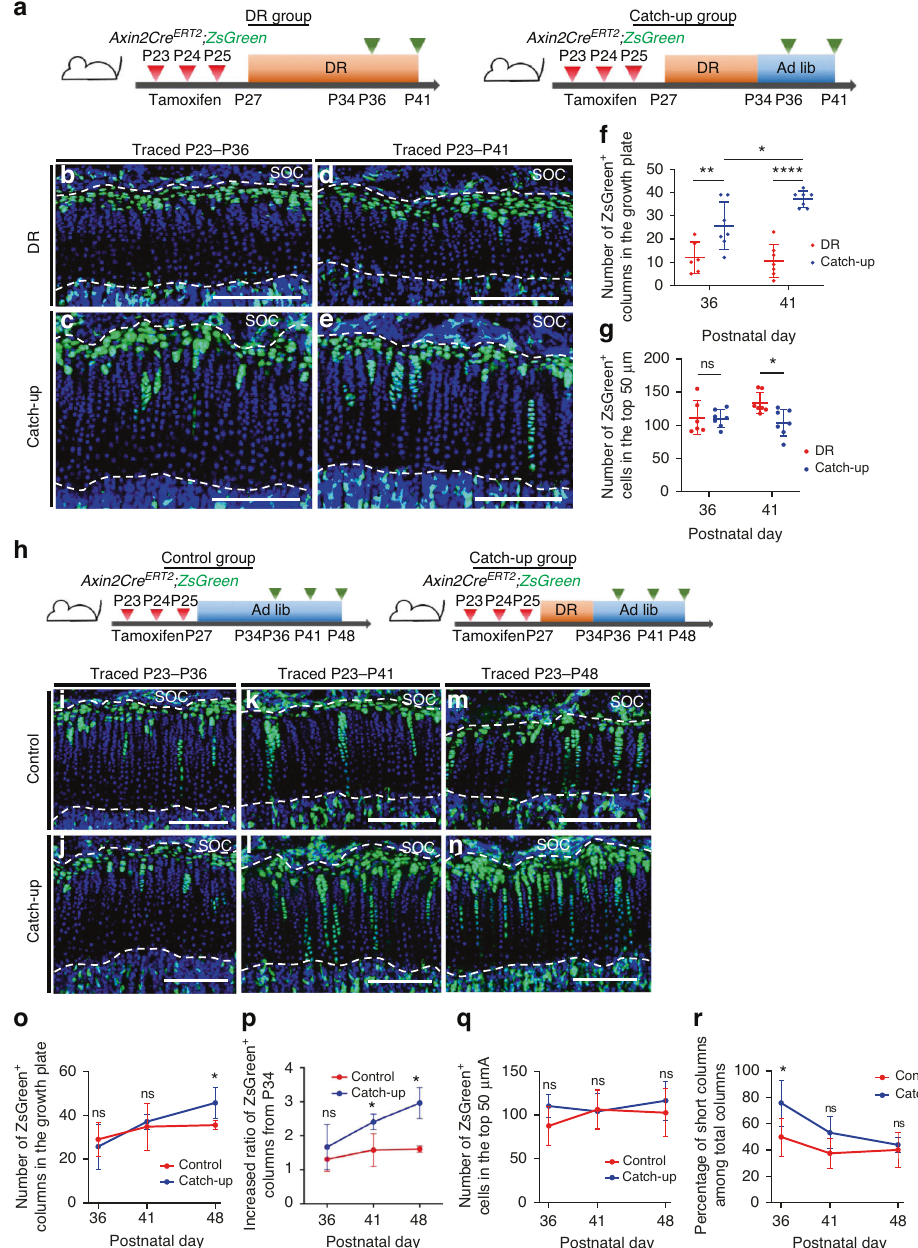
Fig. 4 Ad libitum feeding after dietary restriction promotes committed differentiation of resting chondrocytes. a Schematic diagrams of the fate-mapping analysis of Axin2 + cells in the proximal tibial growth plate in Axin2Cre ERT2 ;R26R ZsGreen mice (pulsed on P23 – 25 and traced for 13 or 18 days). b – e Representative images of descendants of initially labeled Axin2 + cells (ZsGreen + cells) in the proximal tibial growth plate in the DR ( b , d ) and catch-up ( c , e ) groups. f , g Quanti fi cation of the ZsGreen + columns in the growth plate ( f ) and ZsGreen + cells in the top 50 μ m ( g ). DR group ( n = 6), catch-up group ( n = 7) at P36. DR group ( n = 7), catch-up group ( n = 7) at P41. Adjusted * P = 0.022 (P36 vs. P41 in the catch-up group), adjusted ** P = 0.005 2 (DR vs. catch-up, P36), adjusted **** P = < 0.000 1 (DR vs. catch-up, P41) ( f ), adjusted P > 0.999 9 (ns) (DR vs. catch-up, P36), adjusted * P = 0.015 7 (DR vs. catch-up, P41) ( g ). h Schematic of the fate-mapping analysis of Axin2 + cells in the proximal tibial growth plate in Axin2Cre ERT2 ;R26R ZsGreen mice (pulsed on P23 – 25 and traced for 13, 18, or 25 days). i – n Representative image of ZsGreen + cells in the proximal tibial growth plate in the control ( i , k , m ) and catch-up ( j , l , n ) groups. o – r Quanti fi cation of the number of ZsGreen + columns in the growth plate ( o ), the increased ratio of the number of ZsGreen + columns compared to the number at P34 when refeeding started ( p ), ZsGreen + cells in the top 50 μ m ( q ), and percentage of short columns among total columns ( r ). Control group ( n = 7), catch-up group ( n = 7) at P36 and P41. Control group ( n = 6), catch-up group ( n = 6) at P48. Adjusted P > 0.999 9 (ns) (P36), adjusted P > 0.999 9 (ns) (P41), adjusted * P = 0.046 1 (P48) ( o ). Adjusted P = 0.374 3 (ns) (P36), adjusted ** P = 0.004 3 (P41), adjusted **** P = <0.000 1 ( p ). Adjusted P = 0.186 5 (ns) (P36), adjusted P > 0.999 9 (ns) (P41, P48) ( q ). Adjusted * P = 0.042 9 (P36), adjusted P = 0.100 3 (ns) (P41), adjusted P > 0.999 9 (ns) (P48) ( r ). Ad lib ad libitum, DR dietary restriction, ns not signi fi cant, SOC secondary ossi fi cation center. The white dashed lines demarcate the growth plate from the surrounding tissues. Scale bars: 200 μ m ( b – e and i – n ). All data are presented as the mean ± SD. Statistical signi fi cance was determined by two-way analysis of variance and Bonferroni ’ s multiple comparison